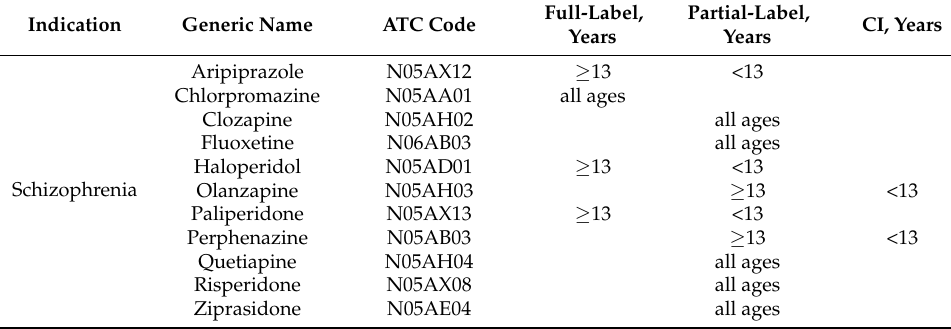
Table 1. Classification of antipsychotic